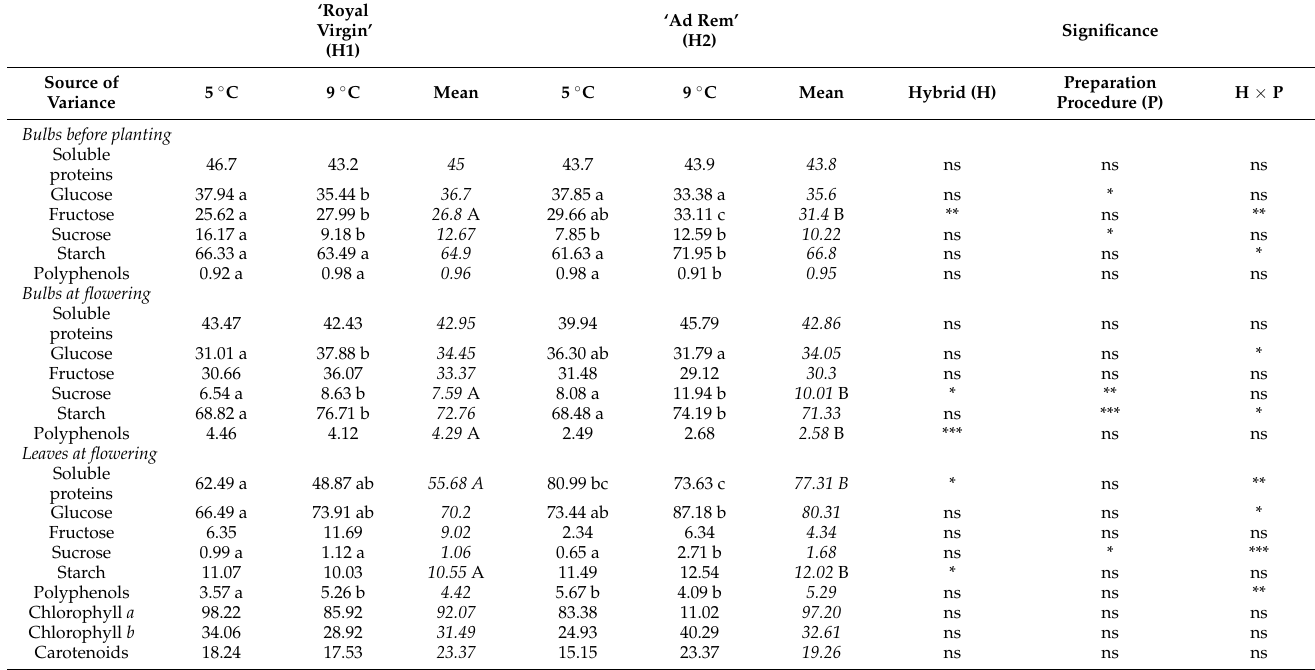
Table 3. Soluble proteins, starch, glucose, fructose, sucrose, (in mg g − 1 DW), chlorophyll a, chloro- phyll b, carotenoids, and polyphenols (in µ g g − 1 DW) in bulbs and leaves of the two hybrids